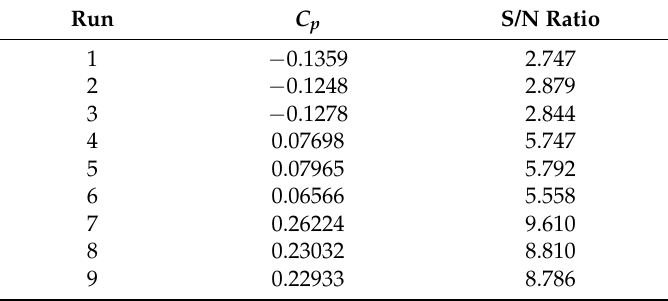
Table 7. Predicted results of C p and signal-to-noise (S/N) ratio in L 9 (3 4 ) orthogonal